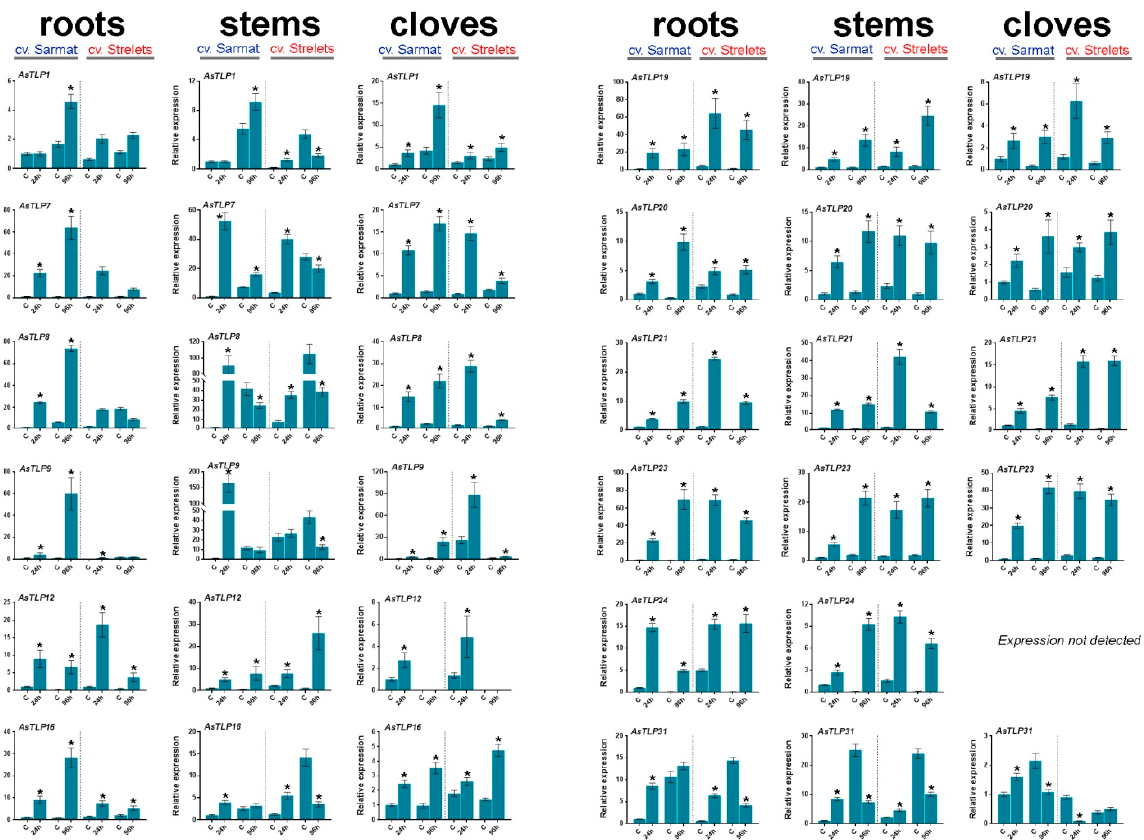
Figure 6. Expression of the AsTLP genes in the roots, stems, and cloves of A. sativum FBR ˗ resistant cv. Sarmat and FBR ˗ susceptible cv. Strelets at 24 and 96 hpi with F. proliferatum . AsTLP8 represents the cumulative data for AsTLP3 , 8 and 10 , AsTLP12 —for AsTLP12 , 15 , 17 , 22 , and 26–29 , and AsTLP19 —for AsTLP13 , 18 , 19, and 30 . Transcription of AsTLP5 , 6 , and 32 was not detected. The data were normalized to GAPDH and UBQ mRNA levels and presented as the mean ± SE ( n = 3) compared to control (cv. Sarmat expression at 24 hpi taken as 1); * p < 0.01 compared to uninfected control. The results revealed that the AsTLP genes were transcribed in all analyzed organs, except for AsTLP24 not expressed in the cloves (Figure 6). To determine the expression of individual genes in clades V and II, we performed sequencing of PCR-amplified products, which revealed that only AsTLP7 and AsTLP31 were transcribed in the tissues of both cultivars. For the other groups of highly homologous AsTLPs , the amplified PCR products were invariable within each